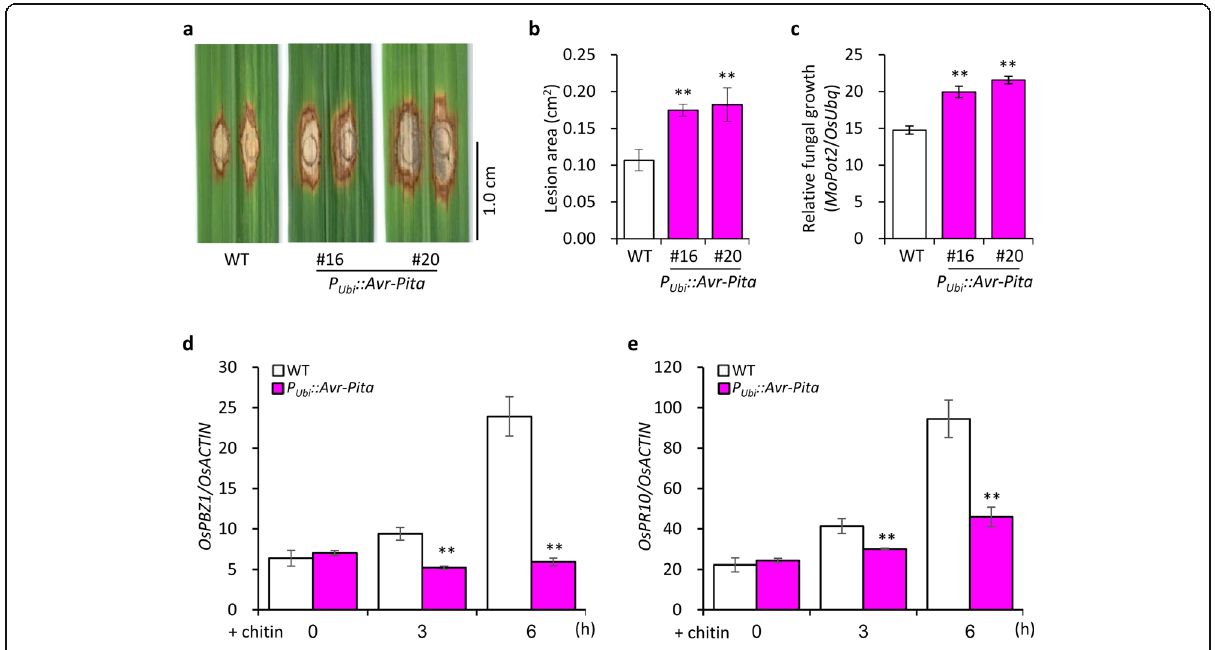
Fig. 1 Overexpressing Avr-Pita suppresses basal resistance to M. oryzae in rice. a Disease symptoms of P Ubi ::Avr-Pita lines and wild-type (WT) plants at 12 days post inoculation (dpi) with compatible isolate 10 – 441 . b Lesion area was photographed and measured using ImageJ software. Data are shown as mean ± standard error (SD) (** P < 0.01, n > 12). c Relative fungal biomass of M. oryzae in inoculated leaves, as quantified by qPCR comparing the DNA amounts of the fungal gene MoPot2 and the rice gene OsUbq . Data are shown as mean ± SD, (** P < 0.01, n = 3).